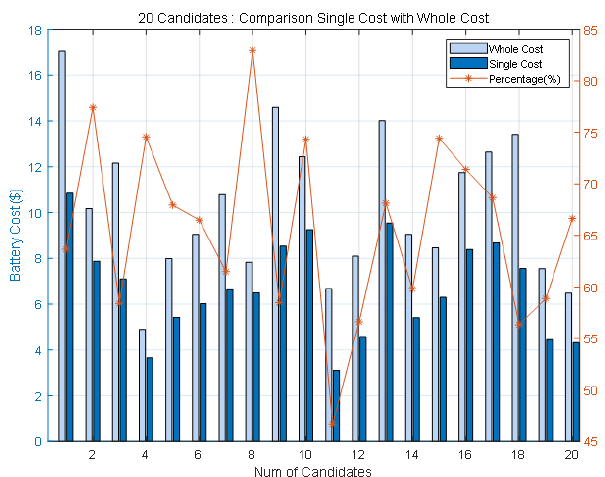
Figure 4. SOC difference (max/min) of the two lifetime costs.